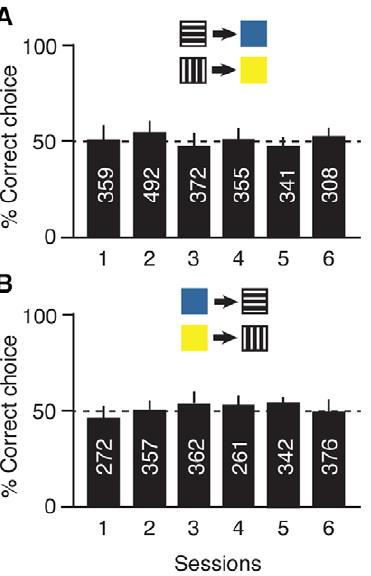
Figure 3. Learning of arbitrary relations in Meliponarufiventris stingless bees. Bars: mean percentage ( 6 s.d.) of correct choices in six rewarded training sessions of seven training blocks each, during which one group of 8 bees learnt the relations patterns-colours (A), and a second group of 8 bees learnt the relations colours-patterns (B). Numbers inside bars indicate the total number of choices per session.